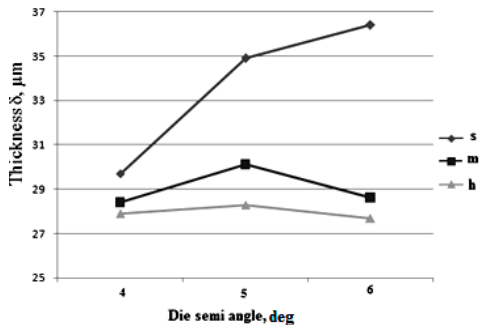
Figure 10. Effect of the die semi-angle on the thickness of the fine grain layer at different friction E ff ect of the die semi-angle on the thickness of the fine grain layer at di ff erent conditions. friction